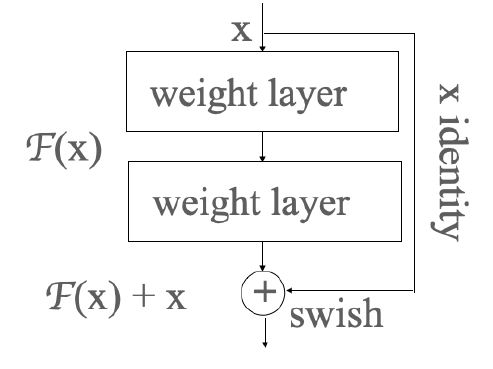
Figure 1. One block in the residual neural network.